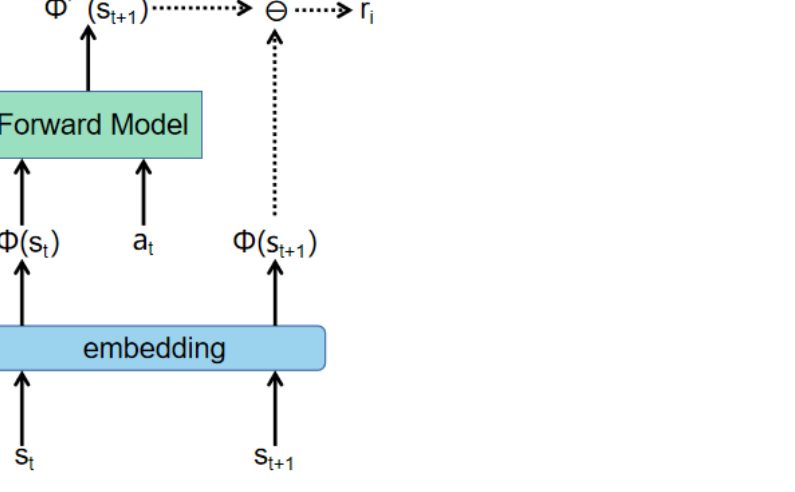
Figure 5. Calculating the intrinsic reward. First embed s t and s t + 1 to get Φ ( s t ) and Φ ( s t + 1 ) , then send Φ ( s t ) and a t to the forward network. The forward network outputs Φ (cid:48) ( s t + 1 ) with the same dimension as Φ ( s t + 1 ) , and then calculate the MSE error of Φ ( s t + 1 ) and Φ (cid:48) ( s t + 1 ) . The MSE is used as an intrinsic reward and becomes part of the reward for the current time step t